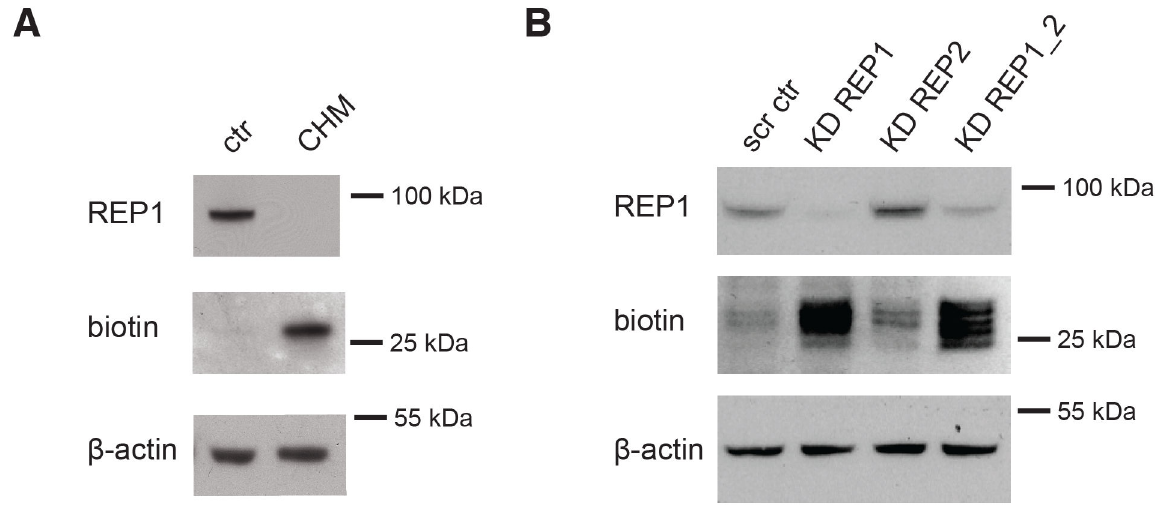
Figure 4. Detection of Rab underprenylation in choroideremia cells and in REP knockdown cells. (A) Lymphoblasts from choroideremia patients (CHM) and control lymphoblasts (ctr) were analyzed for REP1 expression and subjected to in vitro prenylation with BGPP to detect unprenylated Rabs. (B) Western blot analysis of lysate from HeLa cells expressing shRNAs for REP1 (KD REP1), REP2 (KD REP2) and double knockdown of REP1 and REP2 (KD REP1_2). Cells with scrambled RNA (scr ctr) were used as a control. Cells were analyzed for levels of REP1 expression and levels of unprenylated Rabs by in vitro prenylation with BGPP. Since no REP2 antibody of quality sufficient for Western blot analysis was available for our studies the levels of REP2 knock down were inferred by Q-PCR analysis of REP2 mRNA in wild type and KD cells (Figure S1). doi: